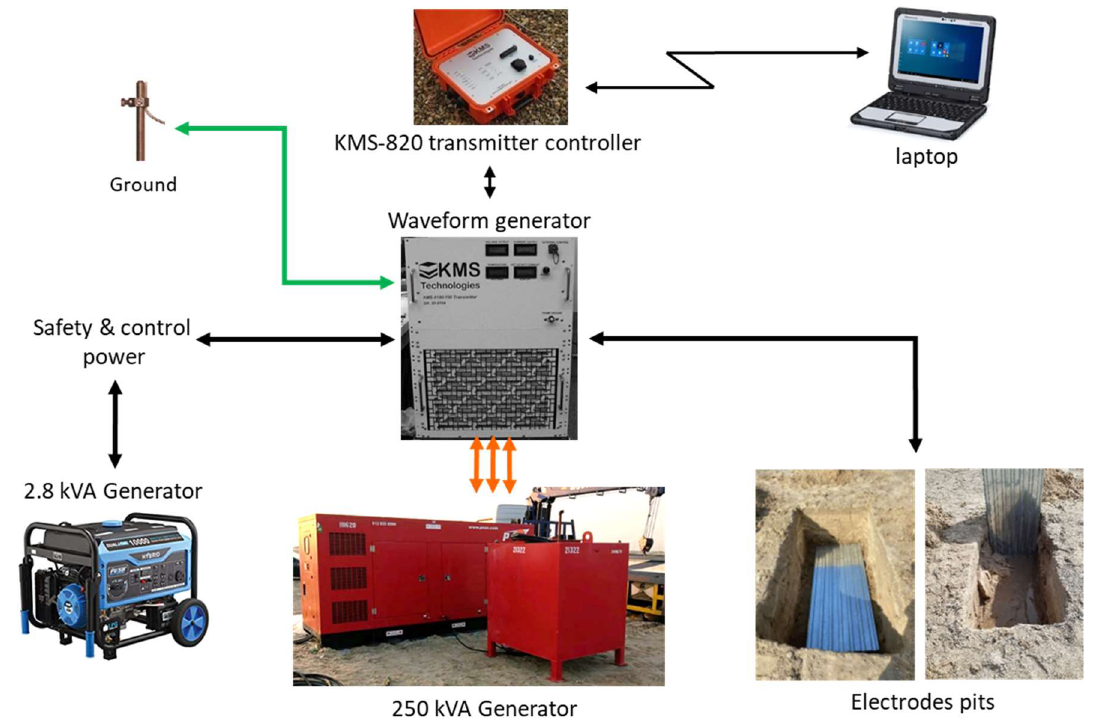
Figure 2. The CSEM configuration used at Half Moon Bay in Saudi Arabia is presented. A 3-phase generator is needed, and the KMS-5100-150 transmitter controller rectifies the current and switches it. A small generator powers the control electronics. The KMS-820 transmitter controller generates waveforms and monitors in the transmitted signal in real time. Electrode pits for current injection are connected directly to the transmitter.